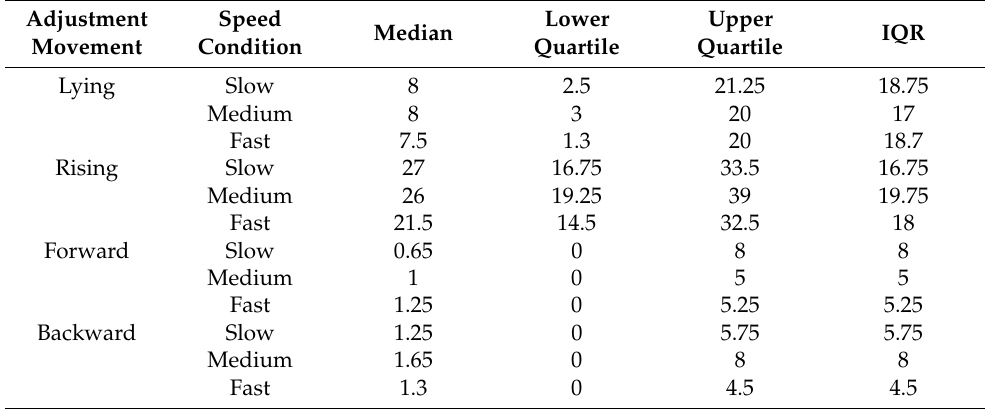
Table 3. Medians, lower and upper quartiles, and interquartile ranges (IQRs) of overall discomfort ratings.